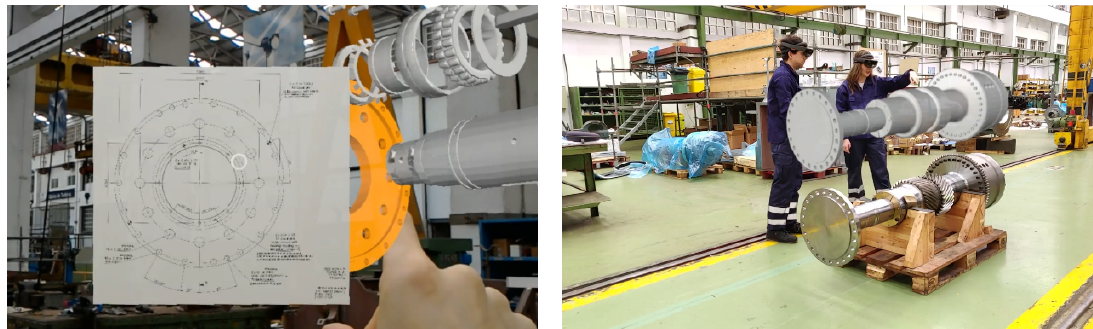
Figure 9. Operator consulting documentation ( left ) and two workers using the shared experience ( right